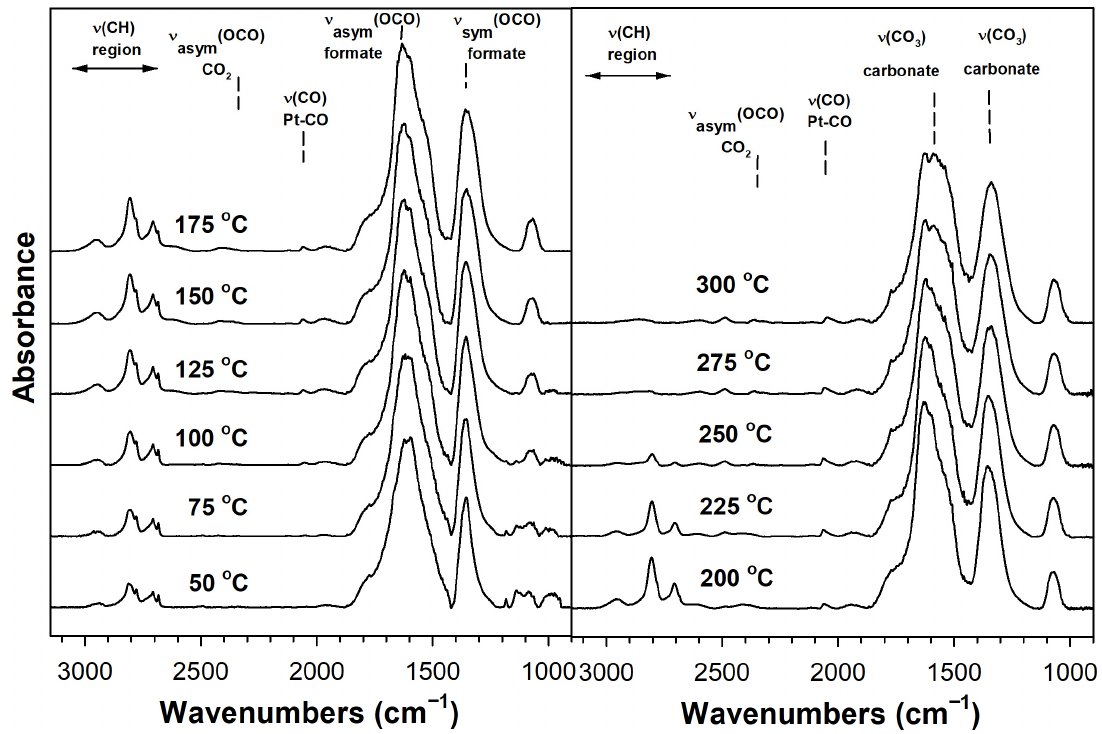
Figure 6. DRIFTS of steam reforming of formaldehyde over 2.5%Na-2%Pt/m-ZrO 2 .